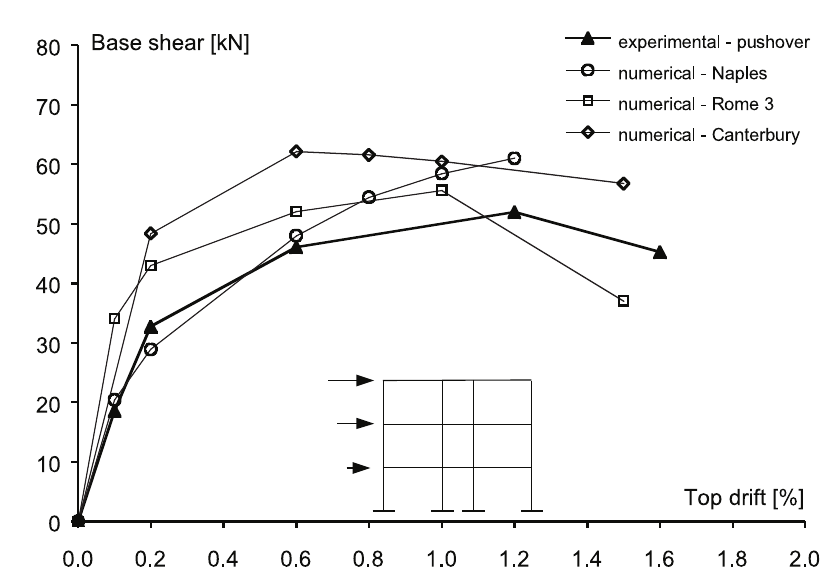
Fig. 6. Blind prediction of the Pavia test